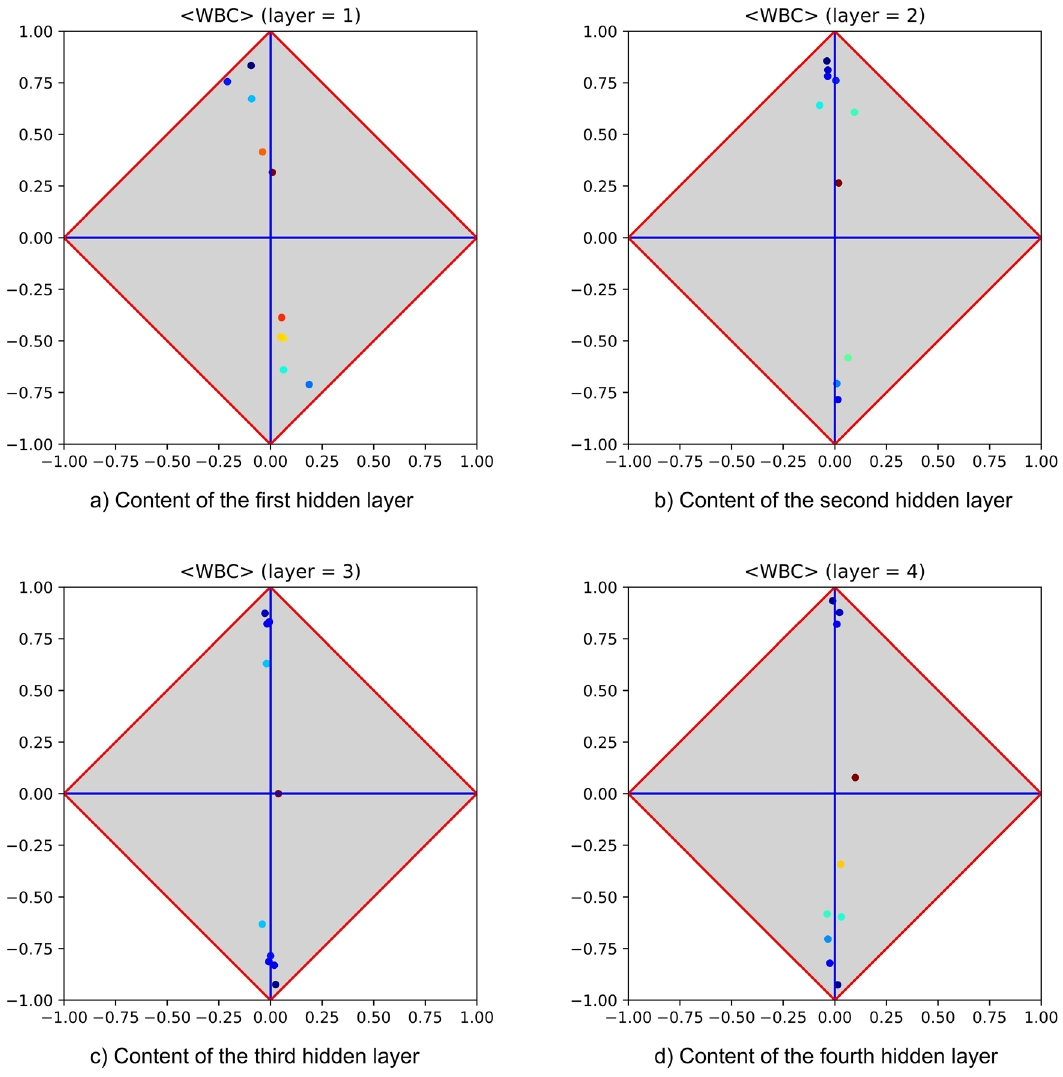
Figure 10. Hidden layers of an MLP trained on the dataset WBC (Wisconsin Breast Cancer) from UCI. To give a flavour of the underlying process, PT has been performed on an MLP architecture equipped with four hidden layers, all with the same number of neurons (i.e., 10). The corresponding signatures highlight that the same pattern of generalisation success is duplicated along the hidden